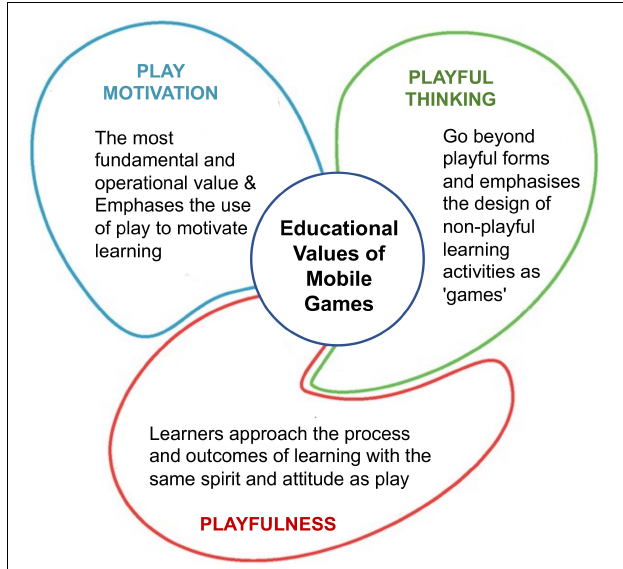
FIGURE 5 | Core educational value of mobile